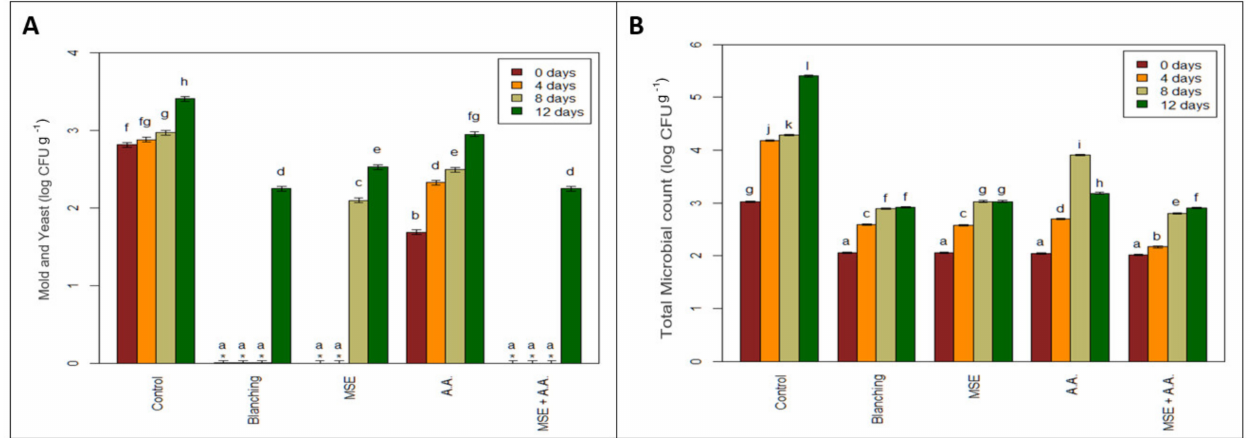
Figure 5. Effect of ascorbic acid (AA), mucilage seed extract (MSE), MSE + A.A, and blanching on mold and yeast (log CFU g − 1 ) ( A ) and total microbial count (log CFU g − 1 ) ( B ) of fresh-cut potato strips. (Means with the same CLD letter are not statistically significantly different. Letters come from holm-corrected multiple comparisons across all times and